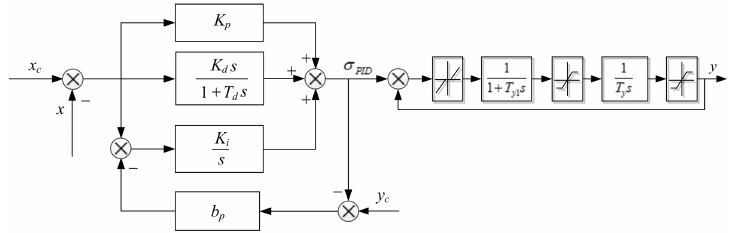
Figure 2. The block diagram of the speed